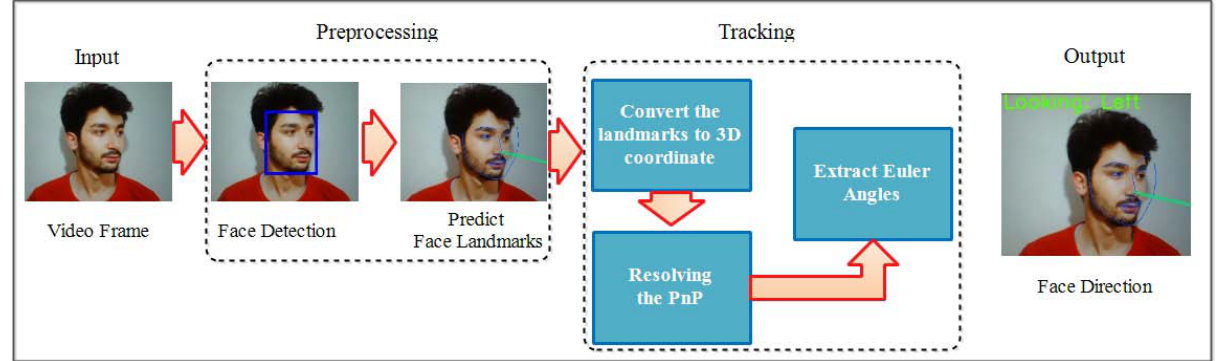
Figure 2 . Face Direction Tracking